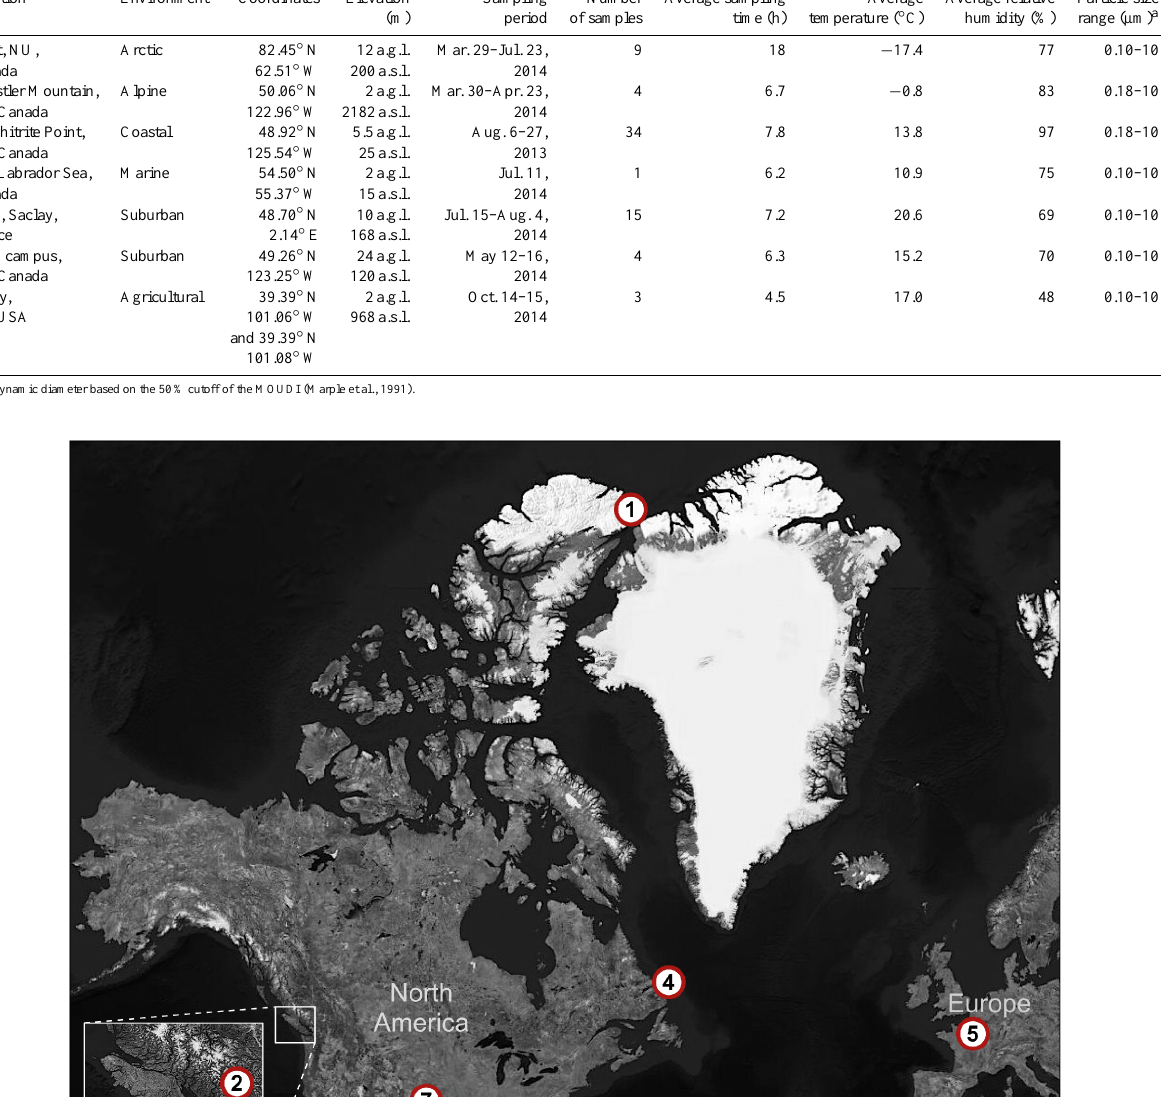
Table 1. The seven locations used in this study and conditions during sampling. Location Environment Coordinates Elevation Sampling Alert, NU,